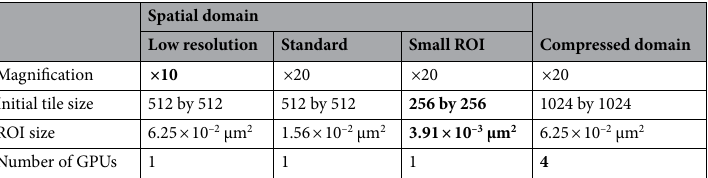
Table 2. The conditions of input image such as magnification, initial tile size, ROI size, and the number of GPUs. Drawbacks in each domain are in bold. Significance values are in bold.